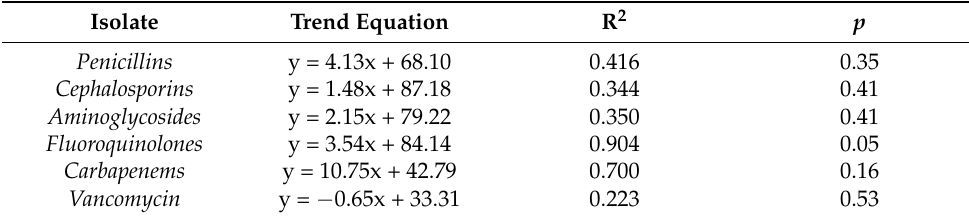
Figure 1. Antimicrobial resistance trends for major antibiotics over four years of surveillance. PCN, penicillins; CEP, cephalosporins; AMN, aminoglycosides; FQ, fluoroquinolones; CBP, carbapenems; VAN, vancomycin. Table 5. Trend analysis for major antimicrobial groups over four years of follow-up.